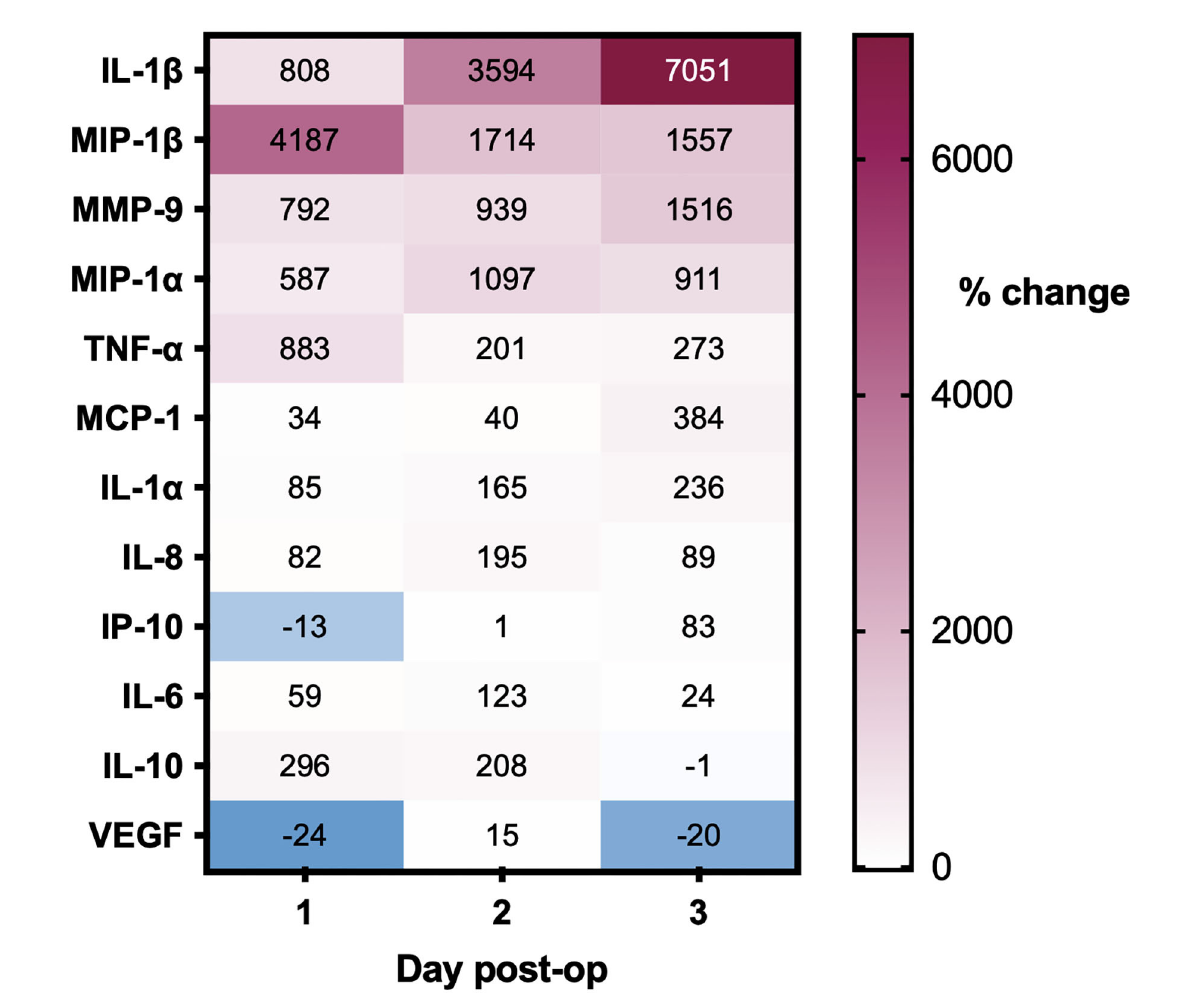
FIGURE6 Percentage changes in CSDH drain analyte concentrations over 3 days post-operatively, all compared to intraoperative CSDH fluid concentrations. Day 1 = 28 samples, day 2 = 10 samples, and day 3 = 4 samples (see full data with standard deviation in Supplementary Table